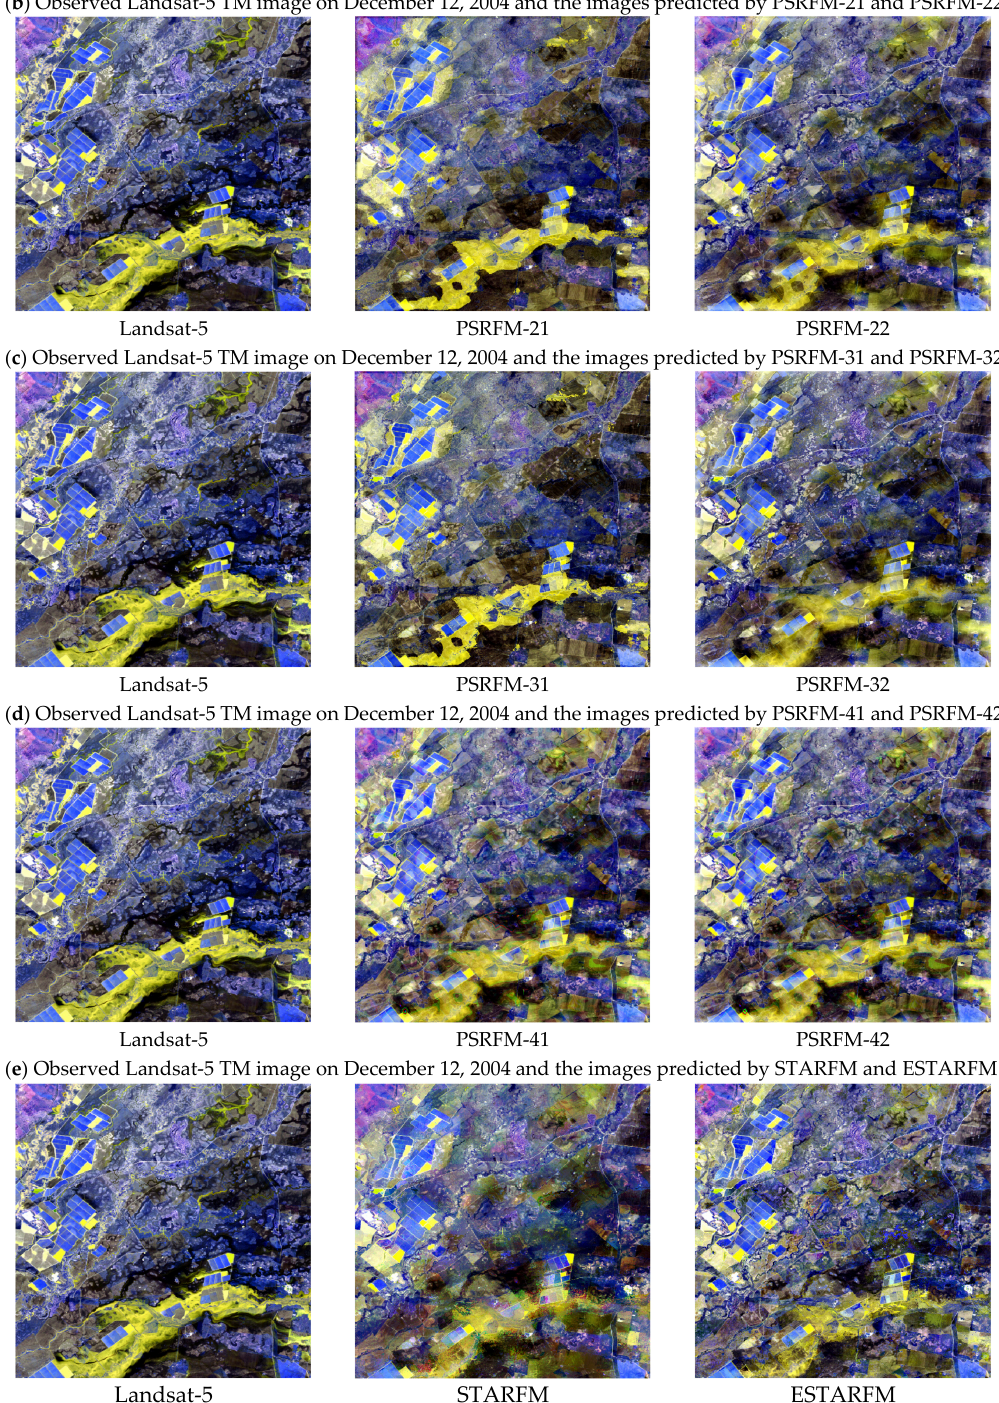
Figure 7. Visual comparisons of the observed Landsat-5 TM image on 12 December 2004 and the predicted images by PSRFM- ij ( i = 1, 2, 3, 4; j = 1, 2), STARFM and ESTARFM using two pairs of Landsat-5 TM and MODIS images acquired on 26 November 2004 and 28 December 2004, respectively. All images are in Red-Green-NIR (R-G-B) false color composites.